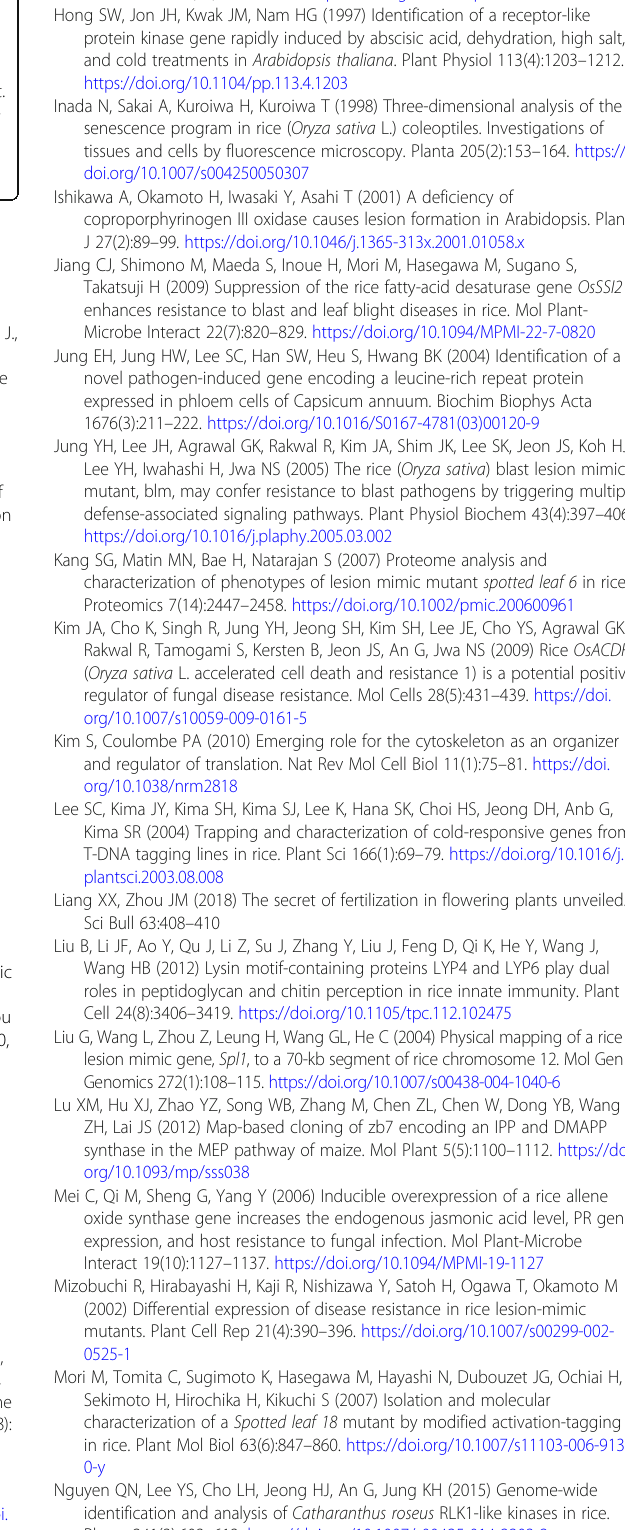
mapping. Table S4. Primers used for vector construction. Table S5. Primers used for qRT-PCR. Figure S1. Analysis of salt stress in wild type and spl36 . A Wild-type and mutant seeds on 200 mM NaCl at 9 days of culture. B Analysis of relative germination rates of wild-type and mutant seeds after salt stress. C Analysis of growth potential in wild type and mutant seeds on 200mM NaCl at 9days of culture. D Analysis of stem length in wild type and mutant plants after 9 days of salt stress treatment. Figure S2. Structural prediction of the protein encoded by SPL36 . A Pre- dicted protein structure of SPL36. B Protein domains of SPL36. C Align- ment of the conserved amino acid sequences of SPL36 homologs in various